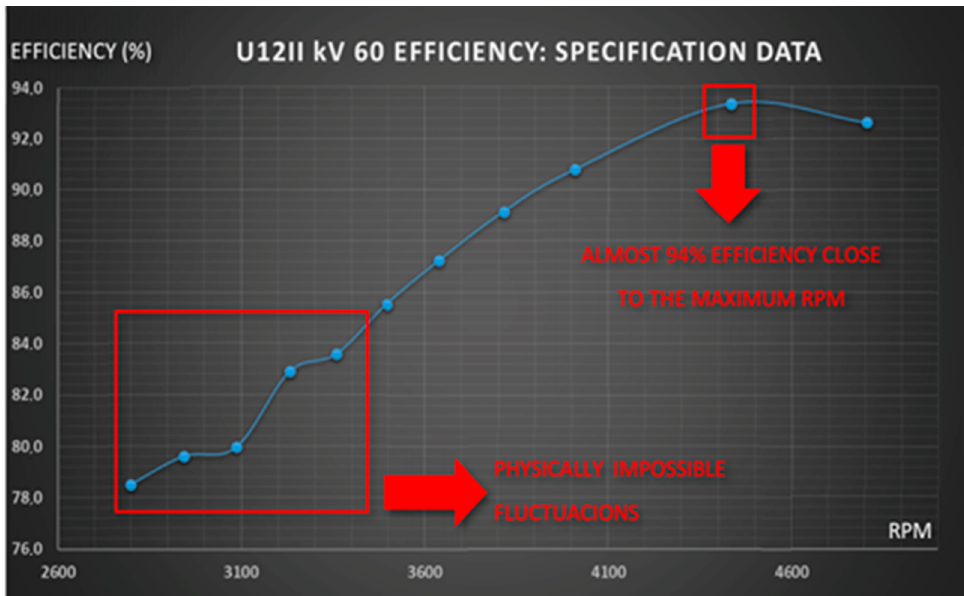
Figure 3. Efficiency of an U812II according to product specifications. Oscillations and a maximum efficiency of nearly 94% at high speed appear.